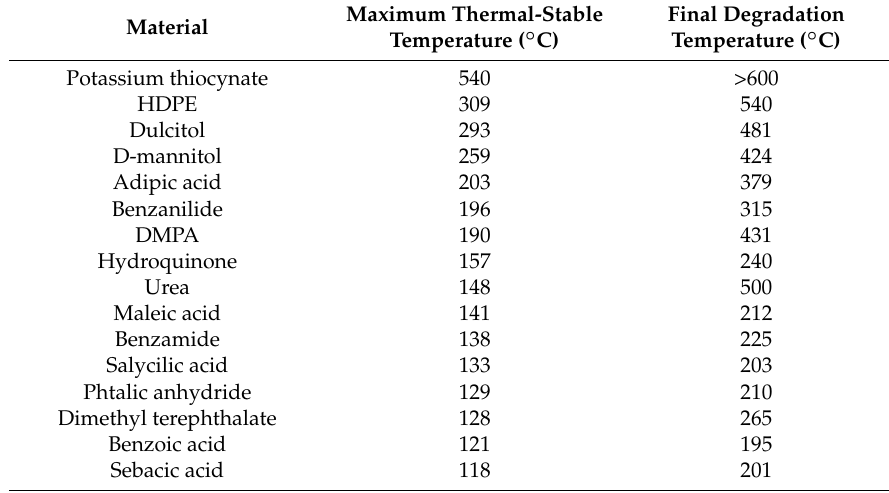
Table 4. Maximum thermal-stable temperature, final degradation temperature of the PCMs under